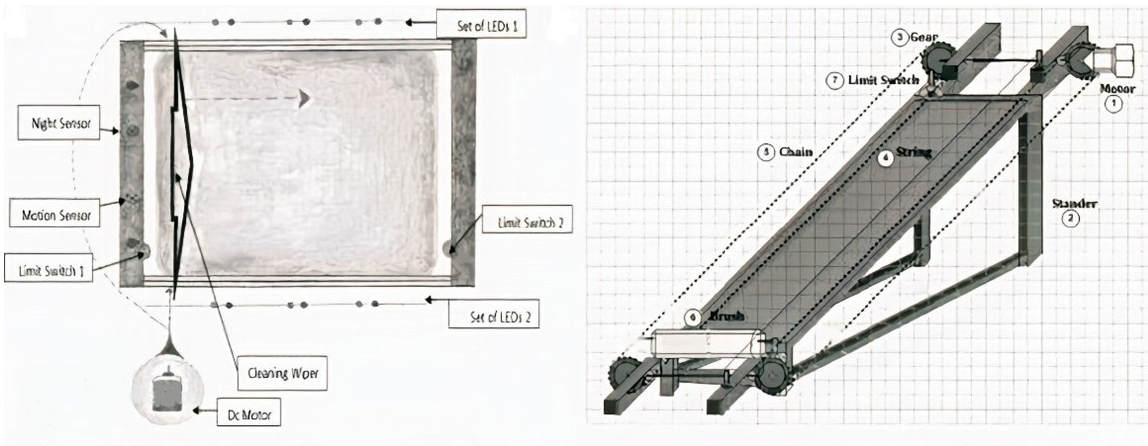
Figure 30. Schematic diagram of an electro-mechanical cleaning system [138].